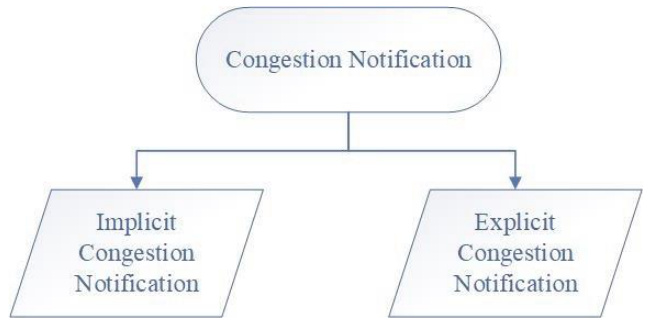
Figure 1. Congestion notification methods.